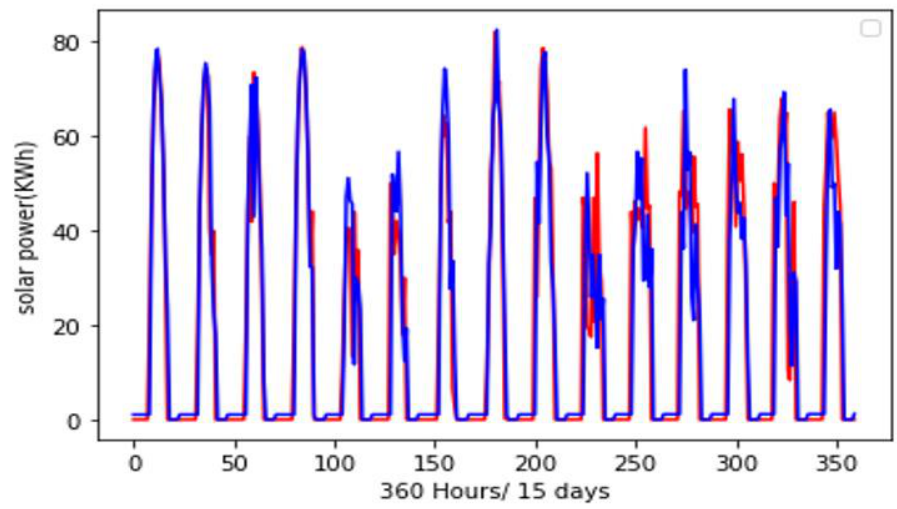
Figure 20. Peformance of the RF model for predicting next 15 days-ahead solar power generation (red line = actual value, blue line = predicted value).